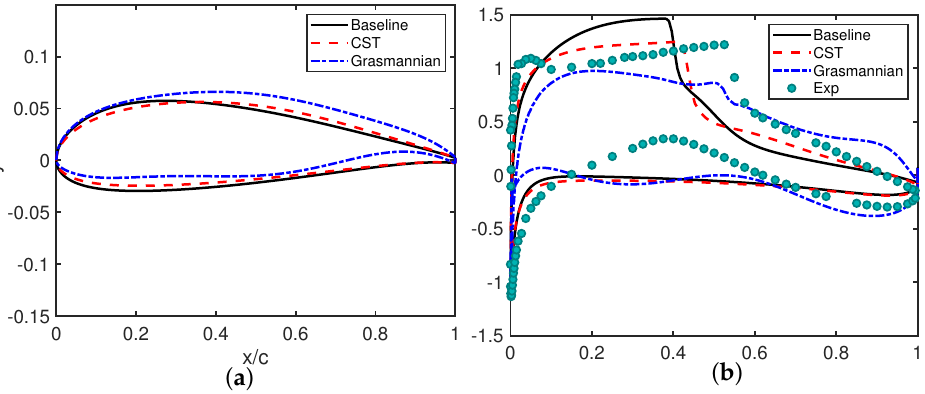
Figure 9. Comparison of the geometry and pressure coefficient of the transonic case of the optimiza- tion from SD7003: ( a ) airfoil shape; ( b ) pressure distribution.